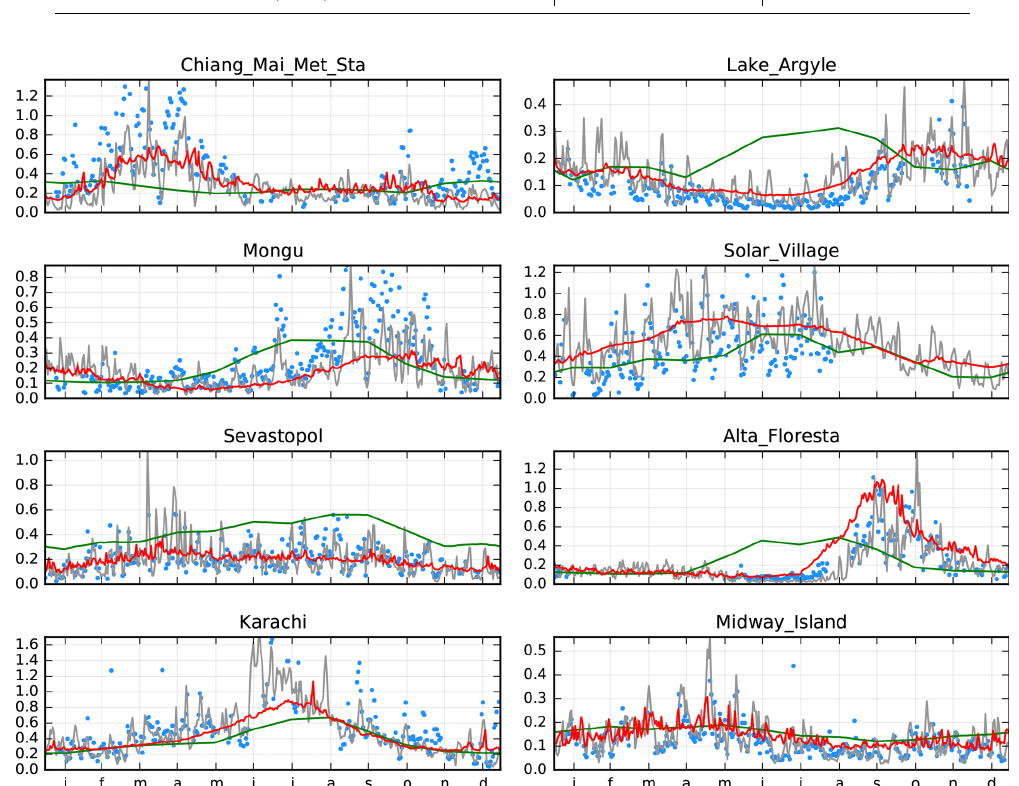
Figure 7. Comparison of daily mean total AOT at 500nm for the year 2008 computed from the climatology presented in this work (red line), from the TG97 climatology (green line) and from the CAMS Interim reanalysis prognostic fields (grey line) at eight AERONET sites. The AERONET L2.0 daily mean observations are shown as blue dots. Please notice the different y axis for each